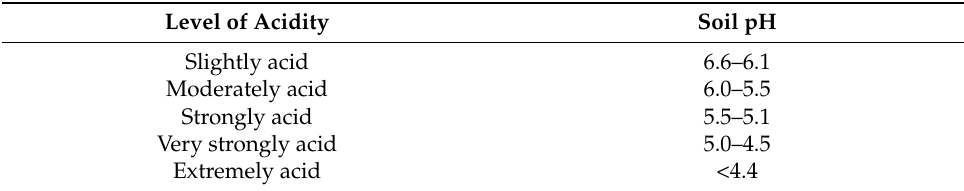
Table 1. Soil acidity range as proposed by McFarland et al.